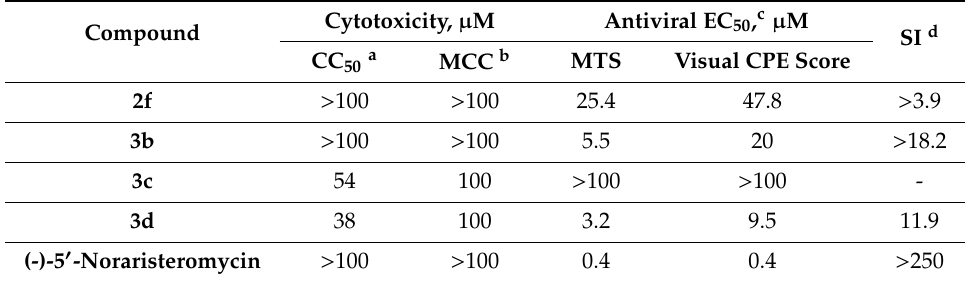
Table 4. Cytotoxicity and antiviral activity against Vaccinia virus in HEL cells.